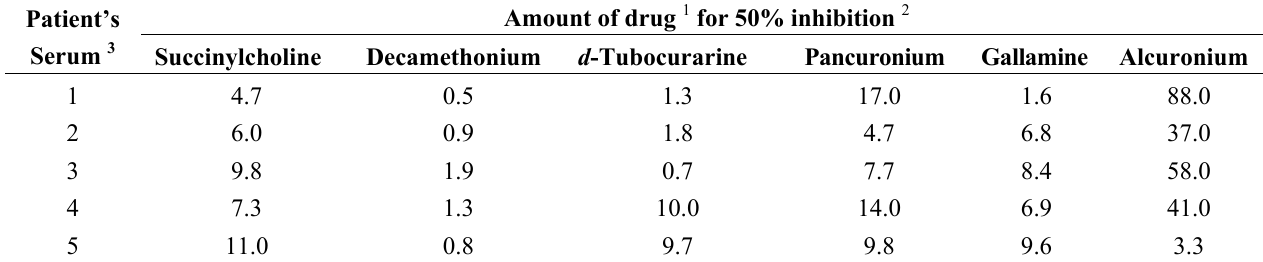
Table 2. Cross-reactivity between neuromuscular blocking drugs (NMBDs). Inhibition by different NMBDs of IgE antibodies to succinylcholine.